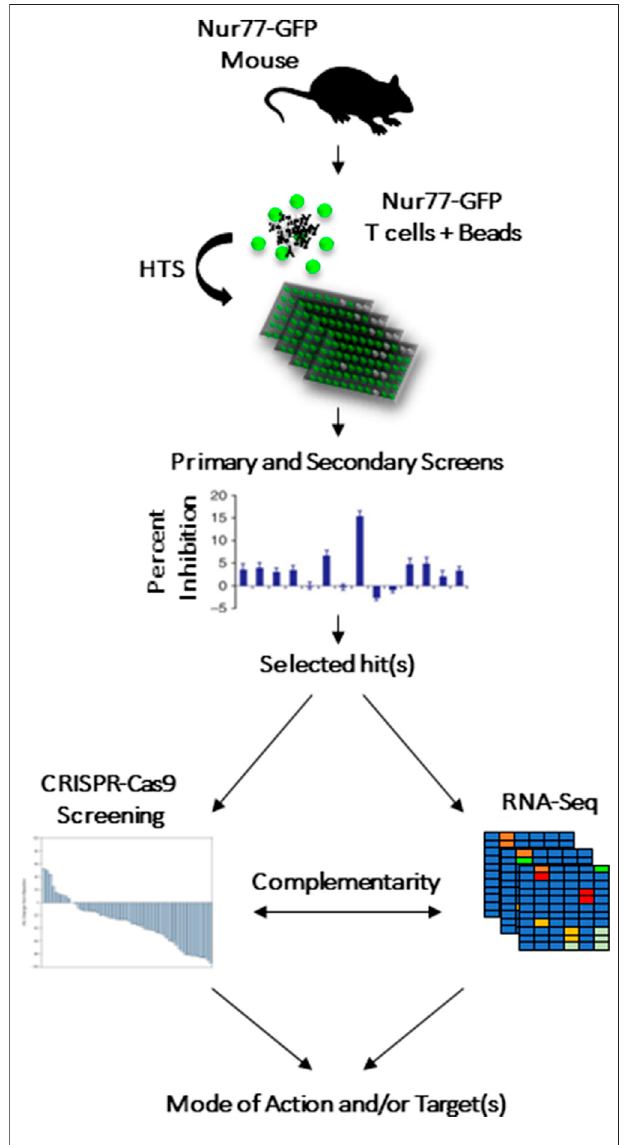
FIGURE 1 | CRISPR-Cas9 and RNA-seq to complement HTS screening as means to highlight the drug ’ s potential target or biological